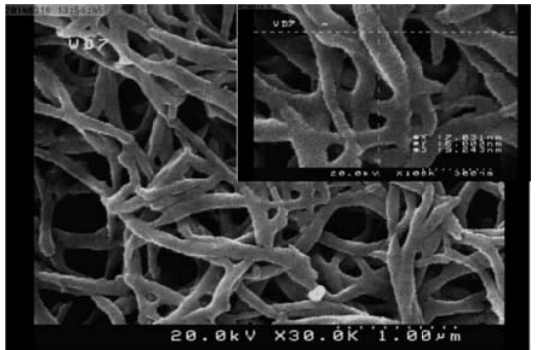
Fig. 1: SEM f 1:1 for Cd: